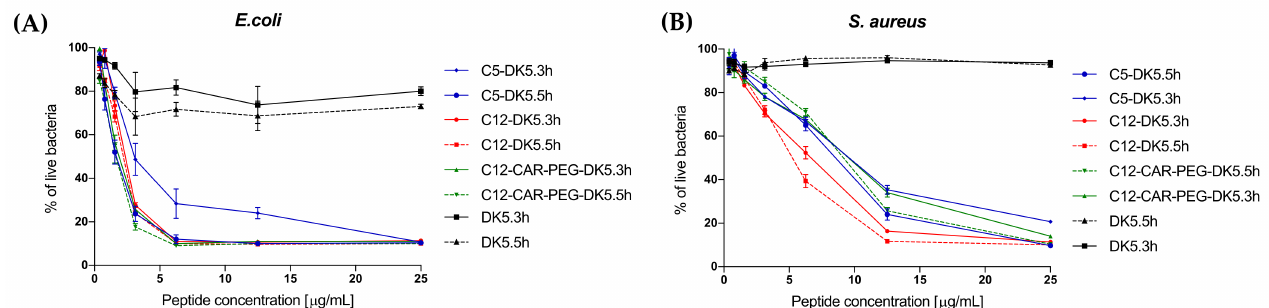
Figure 1. Analysis of the relative viability of E. coli ( A ) and S. aureus ( B ) suspensions in the presence of tested compounds after 3 and 6 h of co-incubation. The relative percentage of live bacteria was calculated from green/red fluorescence ratio for each concentration of the peptides. The data recorded for control probes (bacteria without peptide) incubated under the same conditions in the presence of both dyes (SYTO 9 and propidium iodide) were treated as